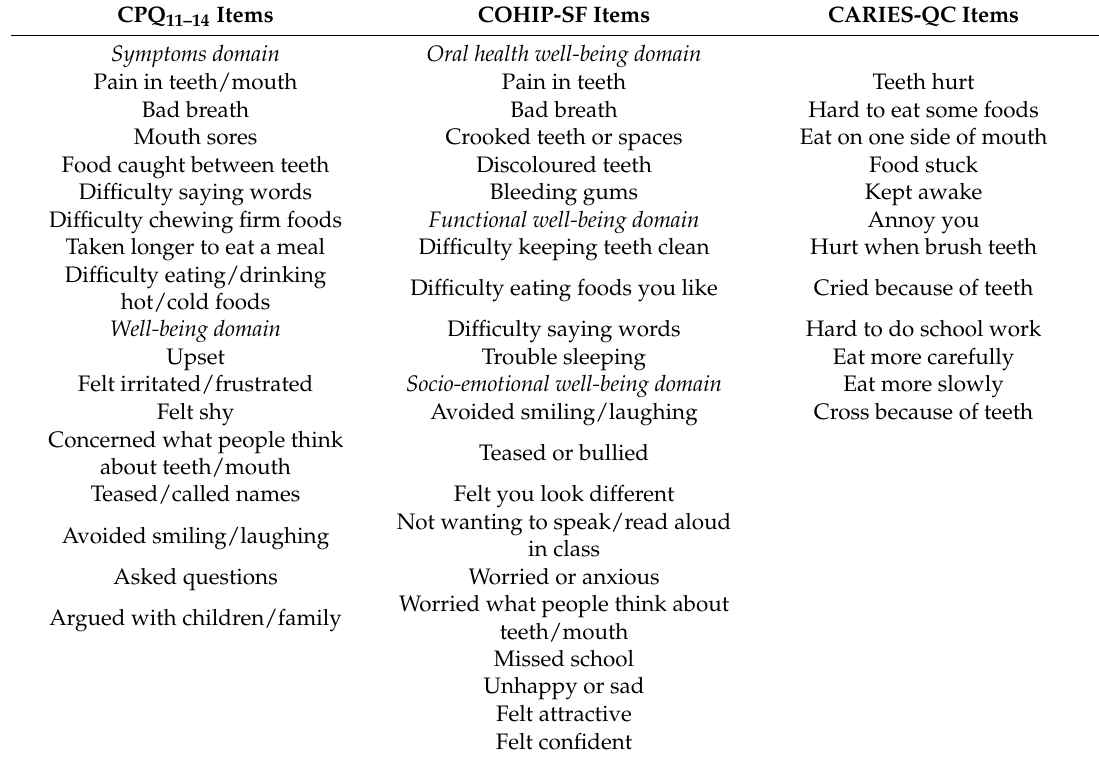
Table 1. Item content of the CPQ 11–14 -ISF:16, SFCOHIP and CARIES-QC